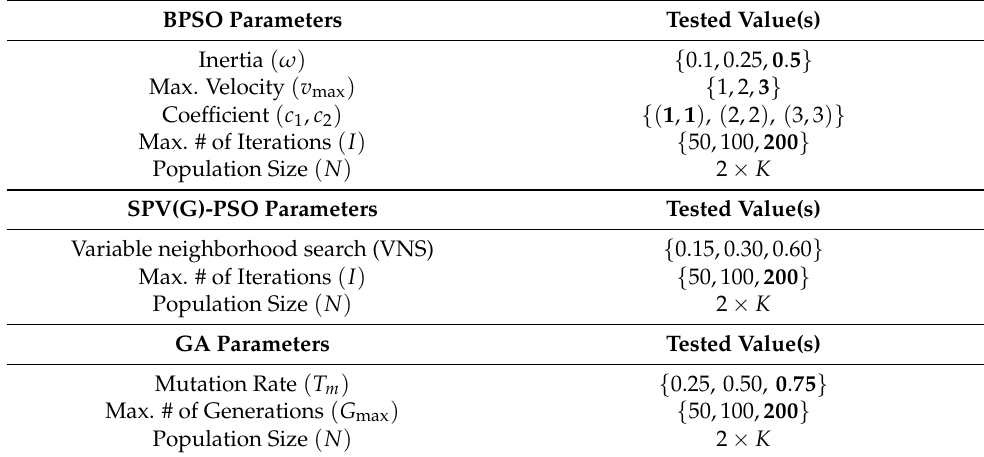
Table 3. Set of tested heuristic parameters. The parameters in bold are the ones which resulted in the best system spectral efficiency.